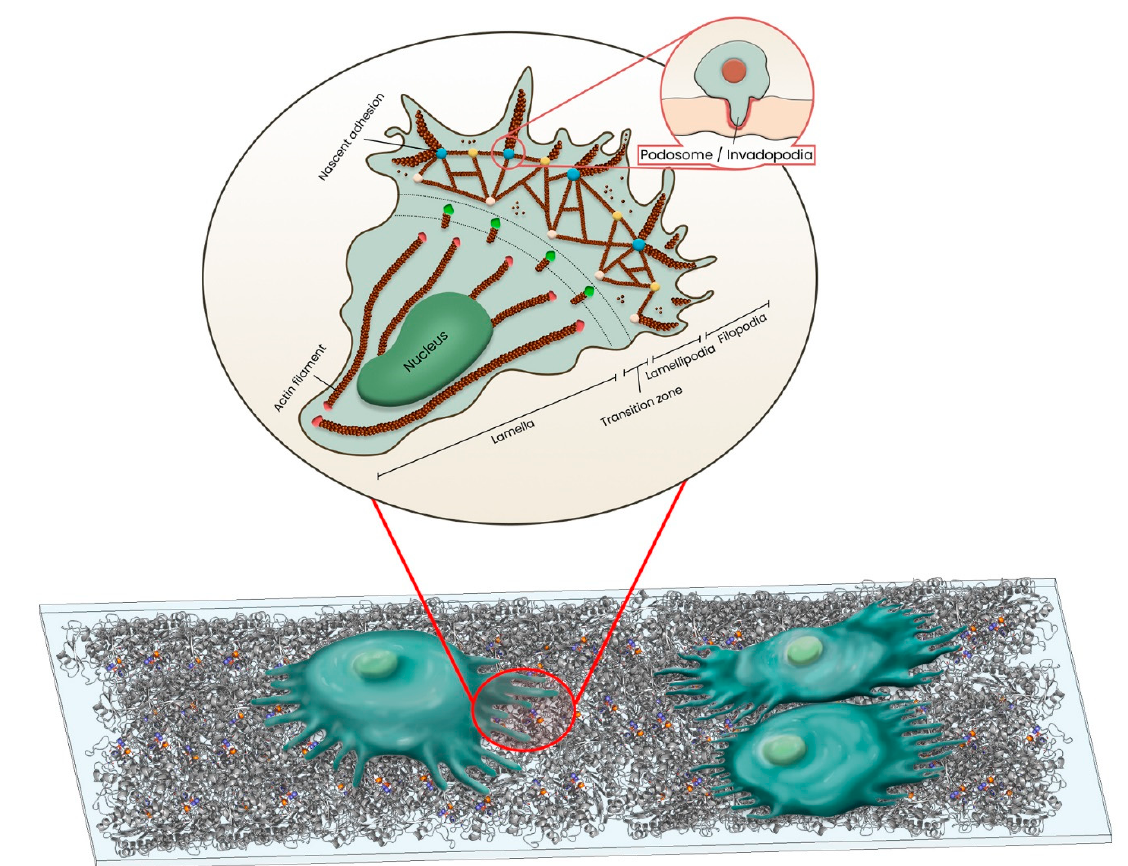
Figure 2. Actin cytoskeleton architecture of a migrating cell. Cell migration is associated with the protrusions emerging at the leading edge of the cell called lamellipodia, filopodia, and po- dosome/invadopodia. However, first, nascent adhesions (blue spheres) are formed in the lamel- lipodia of motile cells. While the formed diffraction-limited nascent can either disassemble (white spheres), if the biomaterial surface does not support cell adhesion, or elongated at the lamellipodia– lamella interface, if the biomaterial surface support cell adhesion. Nascent adhesions elongation is associated with the actin filament bundles, stabilizing the adhesion formation through actomyosin- induced contractility, and increasing the adhesion size which in turn lead to the adhesion maturation to the focal complex (green spheres), located at the transition zone, and focal adhesion (brown spheres), located at the leading edge of the lamella.